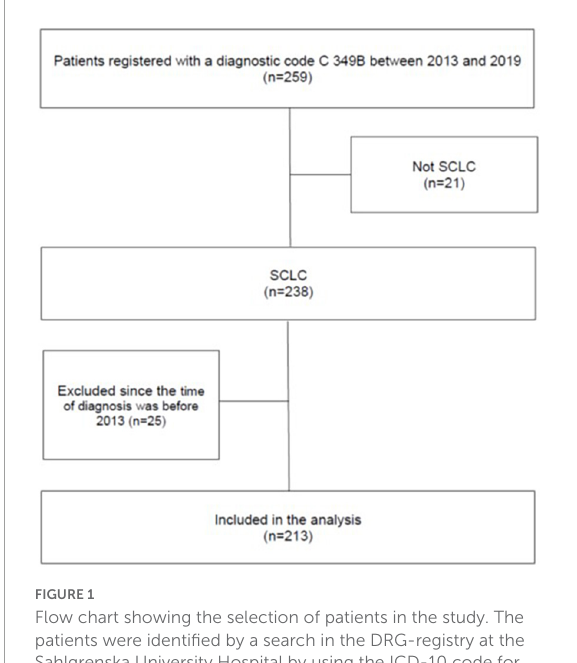
FIGURE1 Flow chart showing the selection of patients in the study. The patients were identified by a search in the DRG-registry at the Sahlgrenska University Hospital by using the ICD-10 code for SCLC.